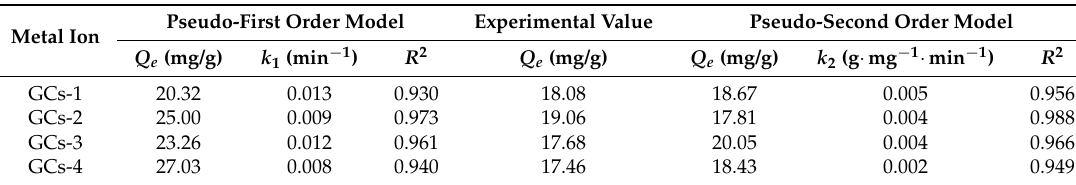
Table 3. Constants and correlation coefficient of pseudo-first order and pseudo-second order kinetics of nickel adsorption.